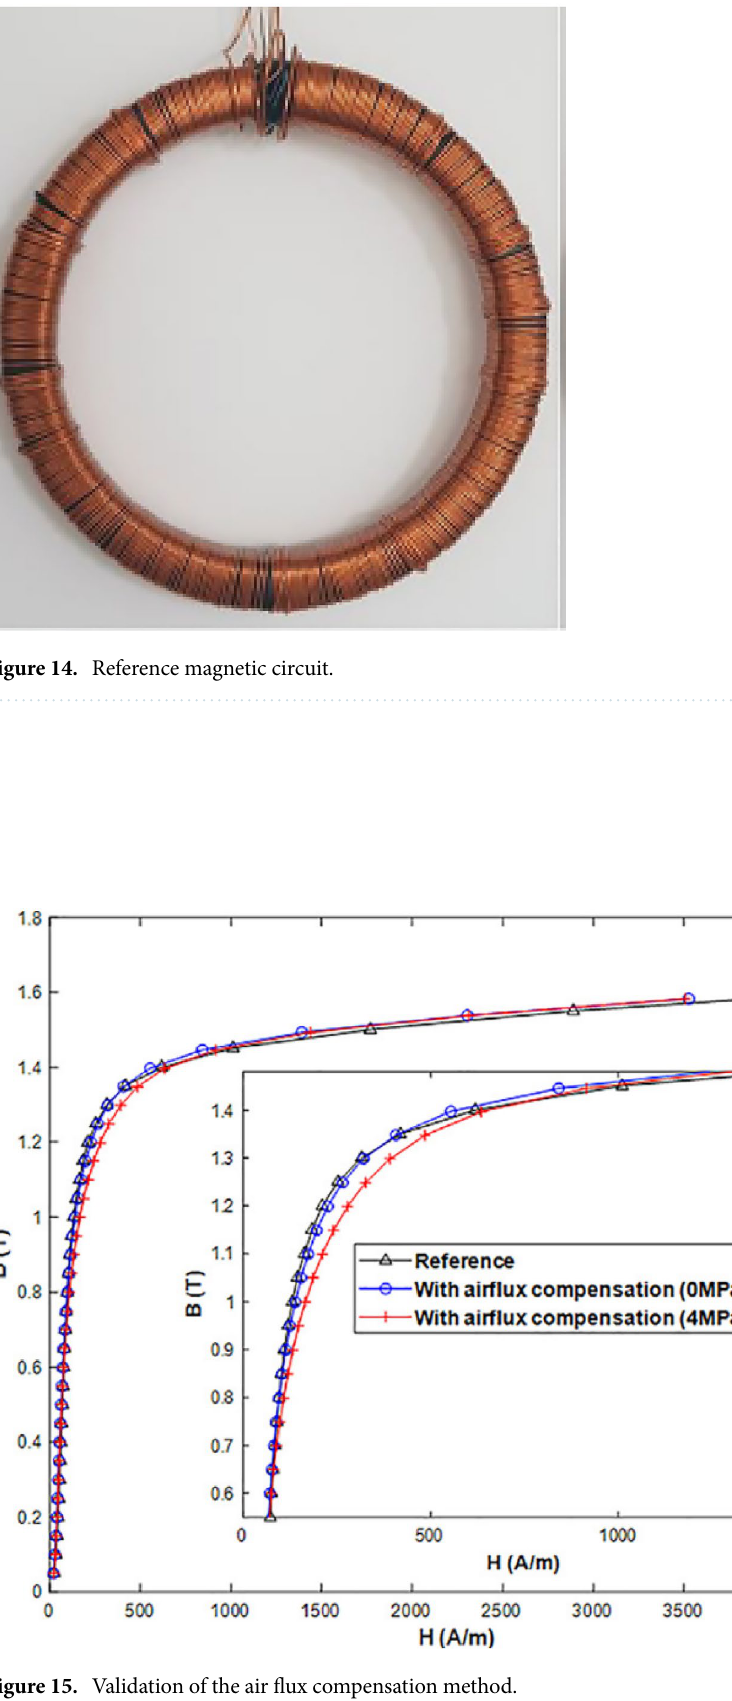
Figure 15. Validation of the air flux compensation